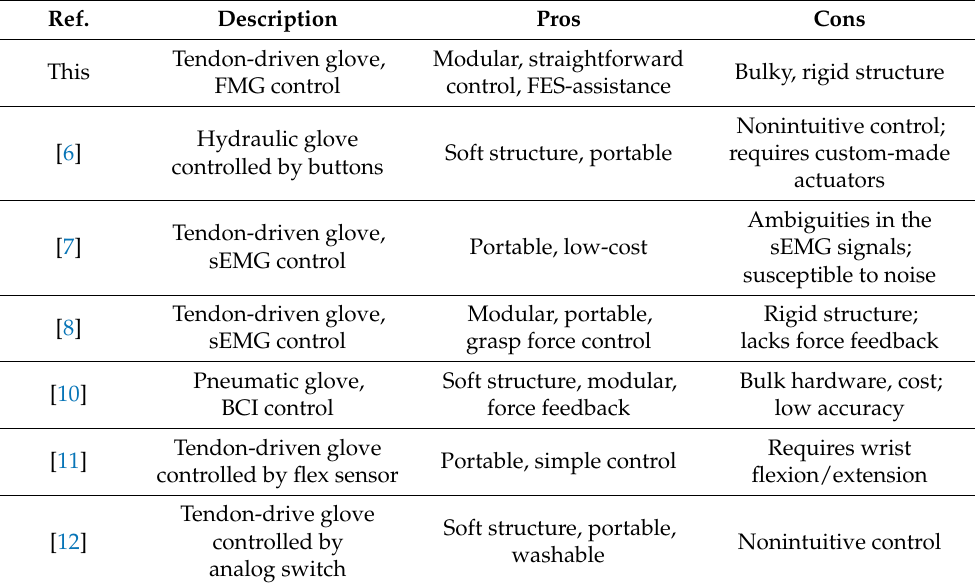
Table 1. Comparison of glove-like